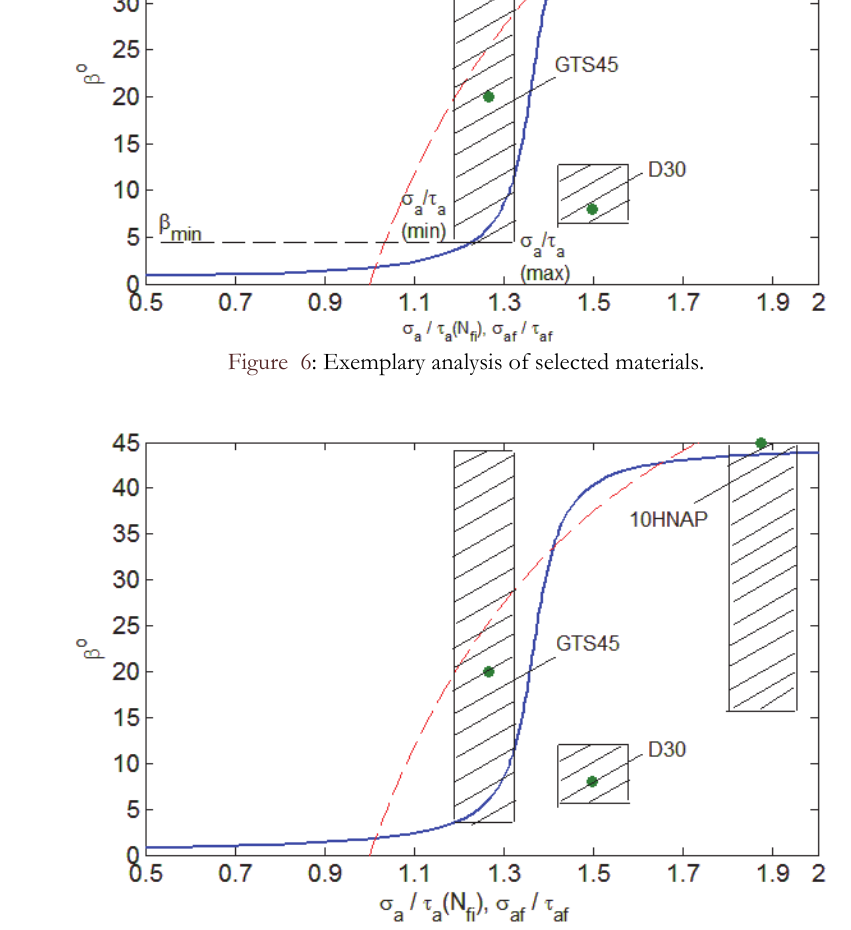
Figure 7: Exemplary analysis of selected